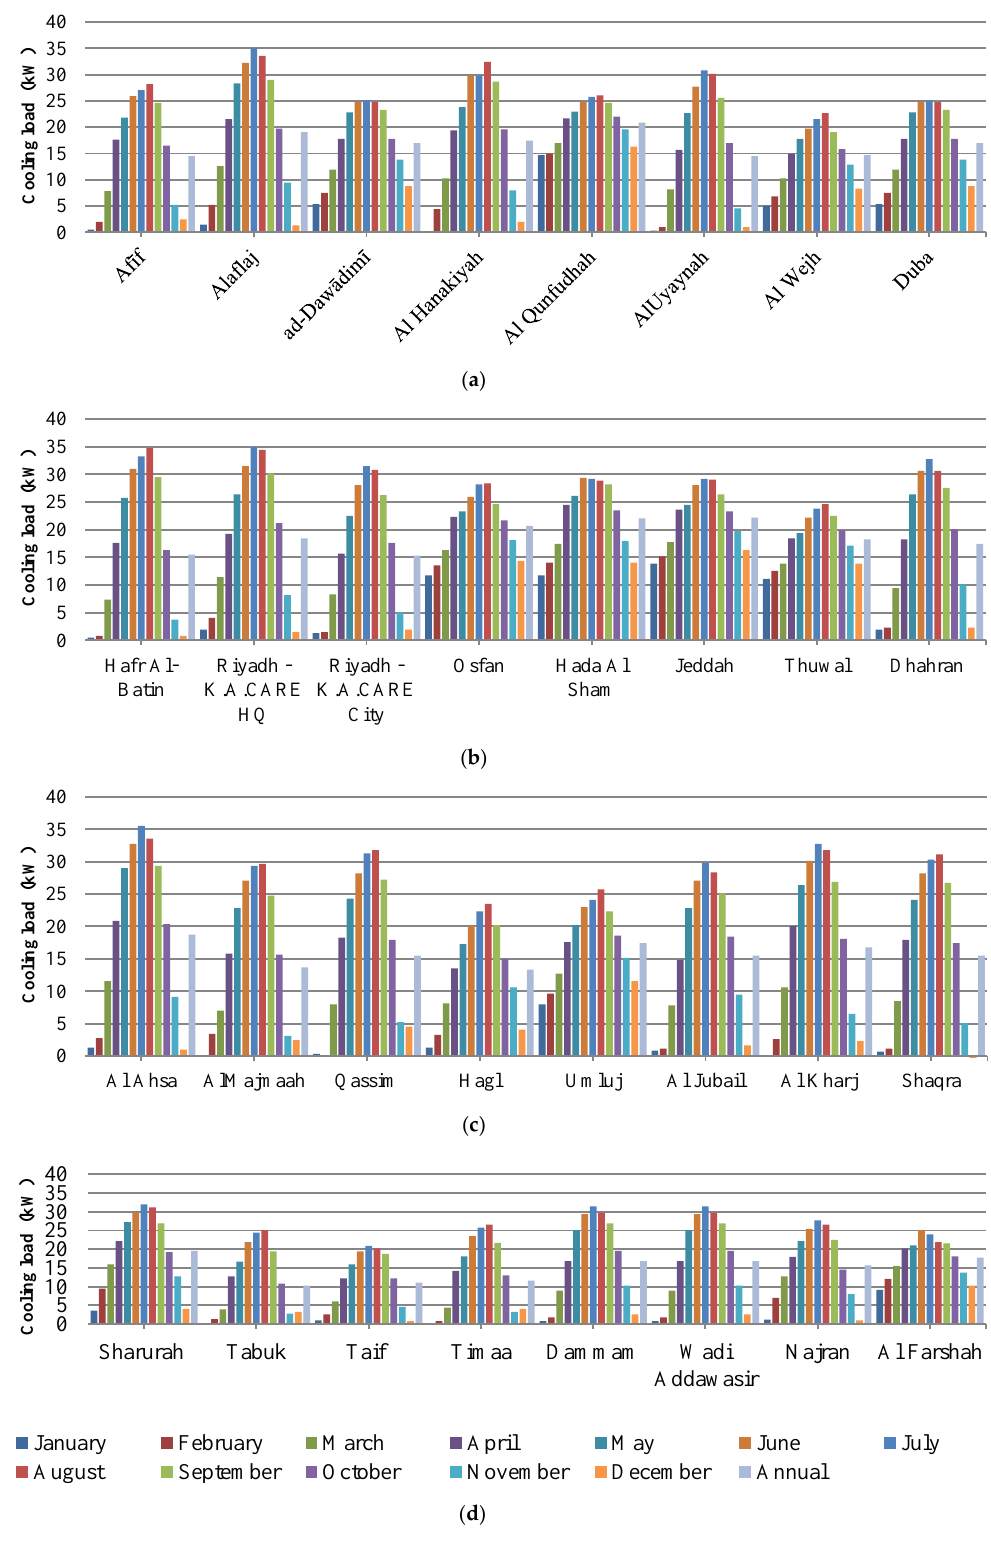
Figure 11. Monthly variations of cooling load for ( a ) Afīf, Alaflaj, ad-Dawādimī, Al Hanakiyah, Al Qunfudhah, AlUyaynah, and Al Wejh, Duba; ( b ) Hafr Al-Batin, Riyadh—K.A. CARE HQ, Riyadh—K.A. CARE City, Osfan, Hada Al Sham, Jeddah, Thuwal, and Dhahran; ( c ) Al Ahsa, AlMajmaah, Qassim, Hagl, Umluj, Al Jubail, Al Kharj, Shaqra; ( d ) Sharurah, Tabuk, Taif, Timaa, Dammam, Wadi Addawasir, Najran, and Al Farshah.